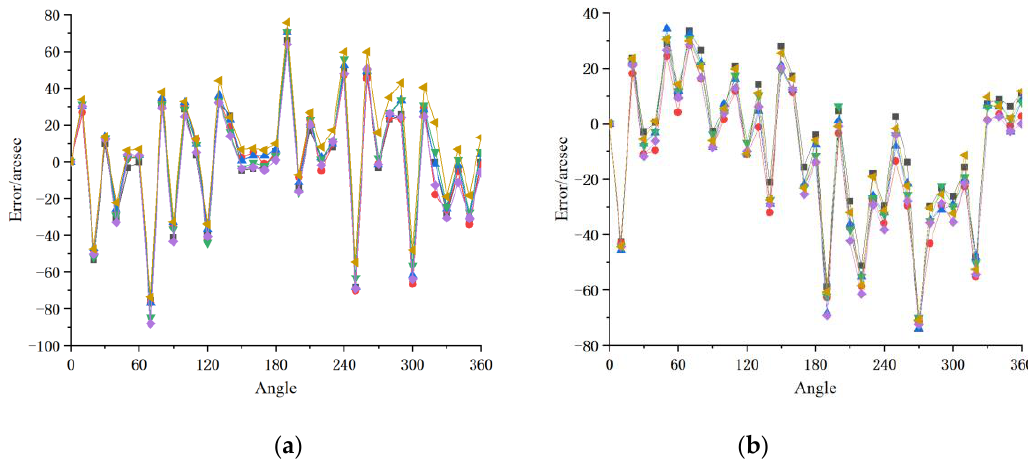
Figure 4. Original experiment error of joint modules: ( a ) joint module a; ( b ) joint module b.